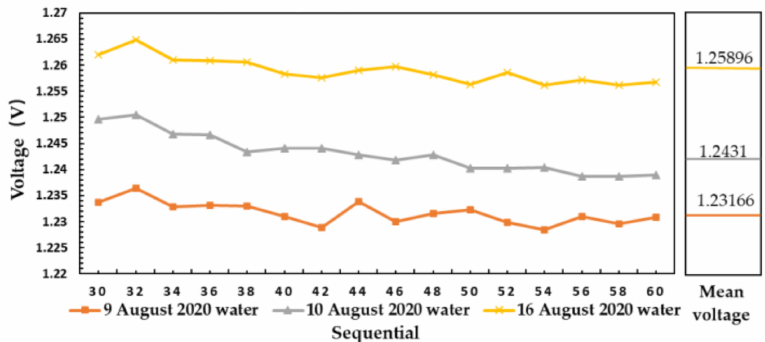
Figure 17. Result of microwave radiometer measuring water at different temperature in different days.